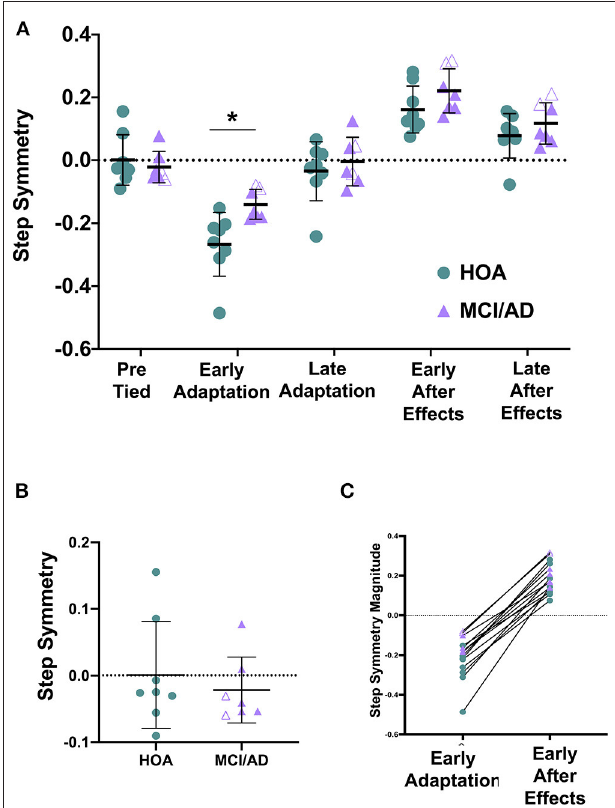
FIGURE 2 | The magnitude of Early Adaptation is significantly reduced in MCI/AD compared to HOA. (A) Two-way ANOVA revealed a significant main effect of group ( p = 0.009) and time ( p < 0.0001) on step symmetry. Pairwise comparisons between groups revealed a significant difference between HOA and MCI/AD at early adaptation (* p = 0.0098). (B) Unpaired t -tests depicted no significant difference in step symmetry during baseline or tied-belt walking between HOA and MCI/AD ( p = 0.532). (C) Comparison of step symmetry (magnitude) during early adaptation and early de-adaptation. Note that the HOA participant data are shown in green circles, MCI participant data in purple filled triangles, AD participant in purple unfilled